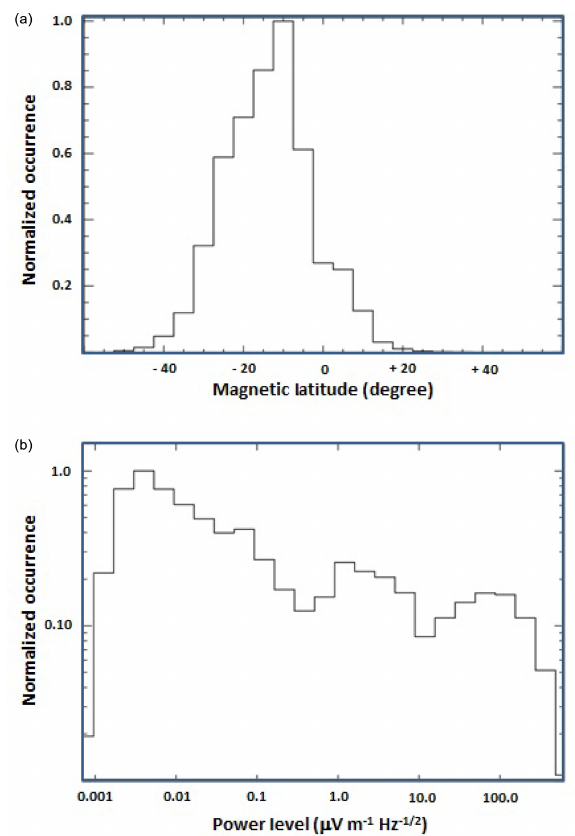
Figure 3. Occurrence of frequency-banded radiations in (a) mag- netic latitude (degrees) and (b) power level (µVm − 1 Hz − 1 / 2 ).